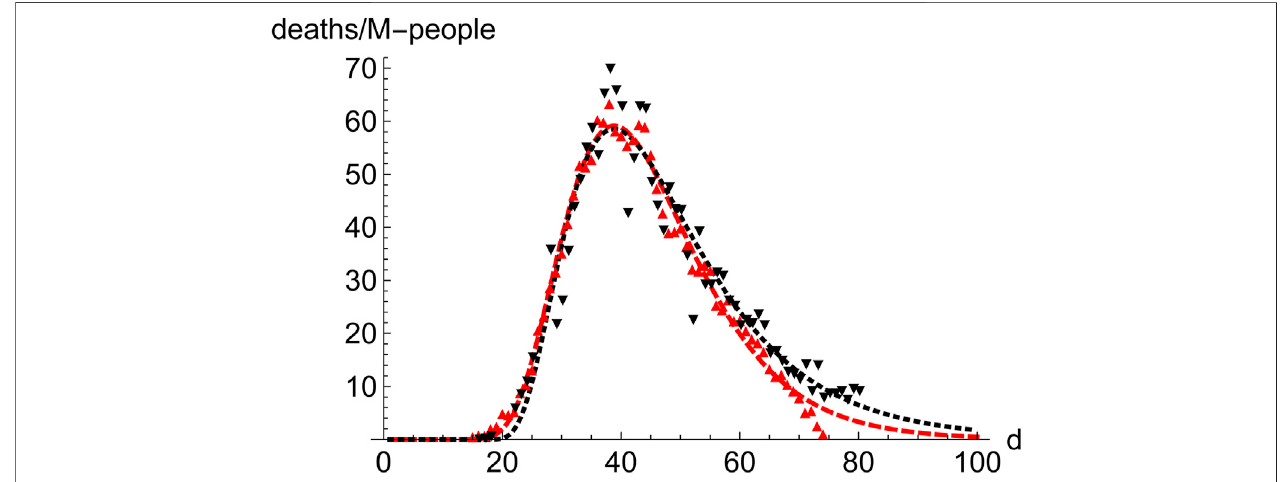
FIGURE5| Comparison oftheevolutionofnumber ofdeaths inNYCand theregion ofMadrid (CAM)during the fi rst wave. NYC(9.1 M people, red, down pointing triangles, ▽ ,dashedline)andMadrid(6.7 Mpeople,black,upwardspointingtriangles, △ ,dottedline)duringthe fi rstwave.ThedataandSHR fi tsforbothlocationswere juxtaposed matching the day with the maximum number of deaths, aiming to highlight the similarities. The values of the CAM were also scaled to the ratio of population (cid:7) to enable a better comparison. between the two regions (cid:6) 9 . 1 7 . 6